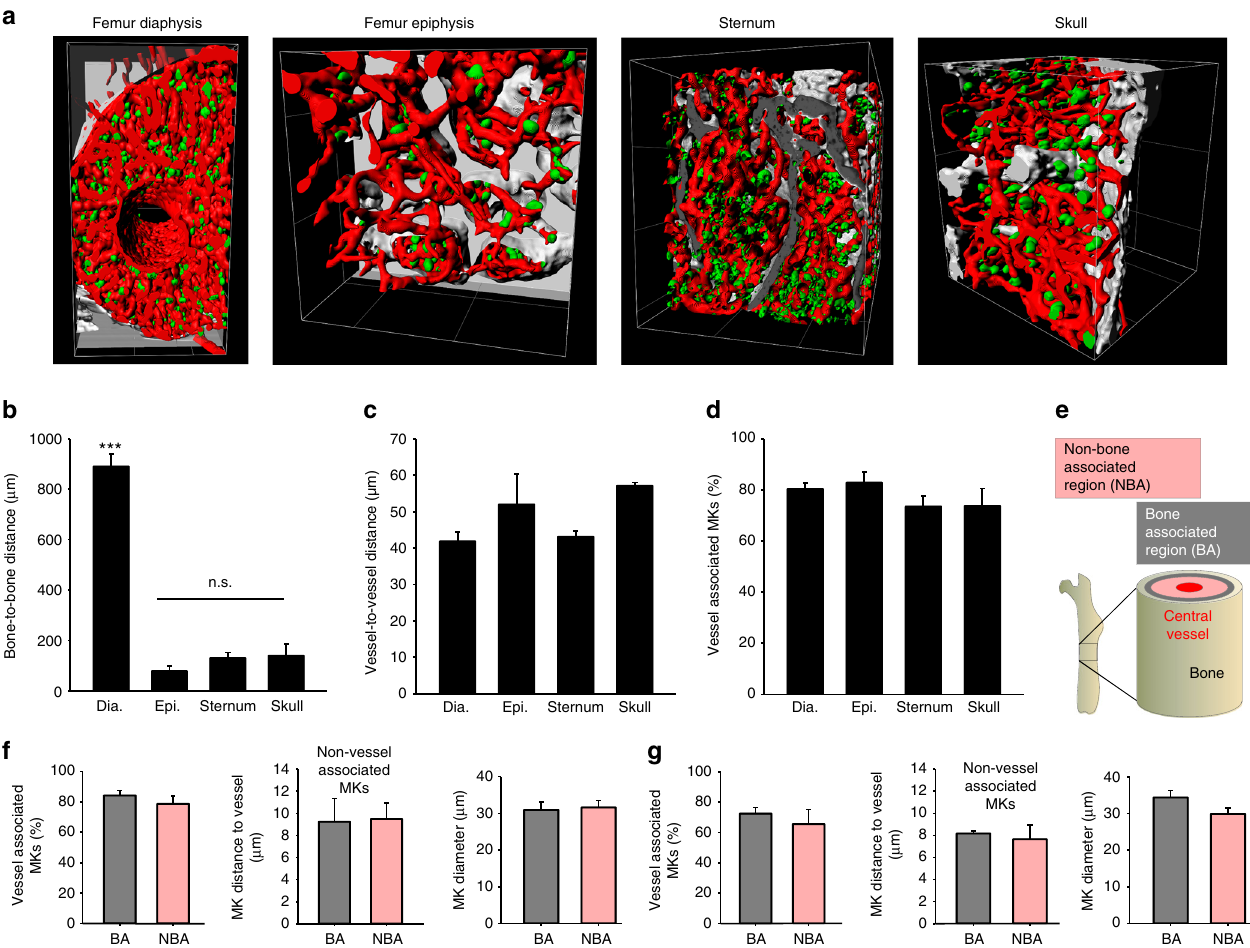
Fig. 4 The inter-bone space is fully vascularized and contains MKs. a Reconstruction of BM along with bone structures for different types of bone revealed that the entire BM contains MKs ( green , GPIX) and blood vessels ( red , CD105). Grid square = 200 µ m. b Quantitative analyses revealed that bone-to-bone distances differ between femur diaphysis (dia.) on the one hand and femur epiphysis (epi.), sternum, skull on the other hand. However, the vessel-to-vessel distances c and the percentage of vessel associated MKs d are comparable. MKs were grouped in bone associated (BA) or non-bone associated (NBA, more than 100 µ m distance from the bone cortex) as depicted schematically e . A subsequent analysis of MK parameters for femur f or sternum g revealed that the percentage of vessel-associated MKs, the MK distance to the vessel of non-vessel-associated MKs or MK diameters were similar between BA and NBA MKs in both types of bone. Bar graphs represent mean ± SD; n = 4; *** p < 0.001 (Mann – Whitney U